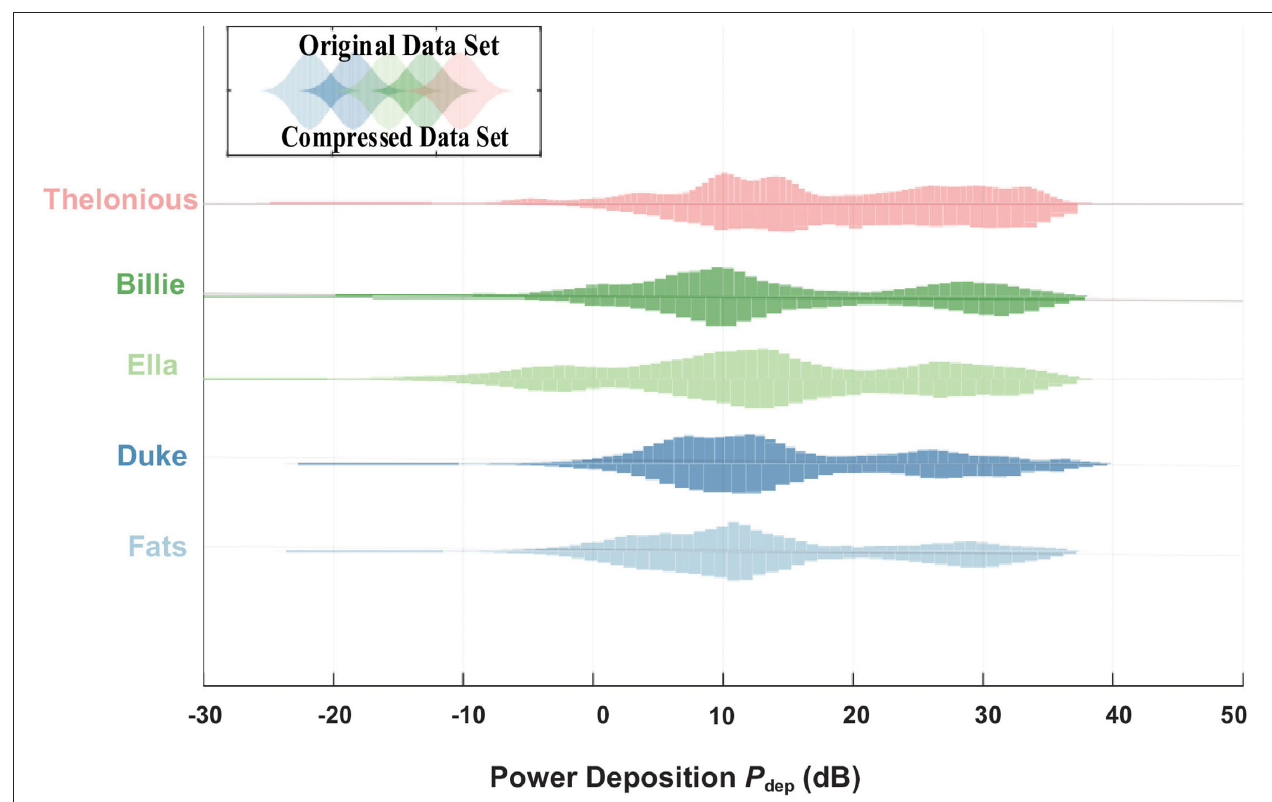
FIGURE 5 | Power deposition ( P dep ) distribution of the original data set from the data library (up) and compressed data set by PCA (down).